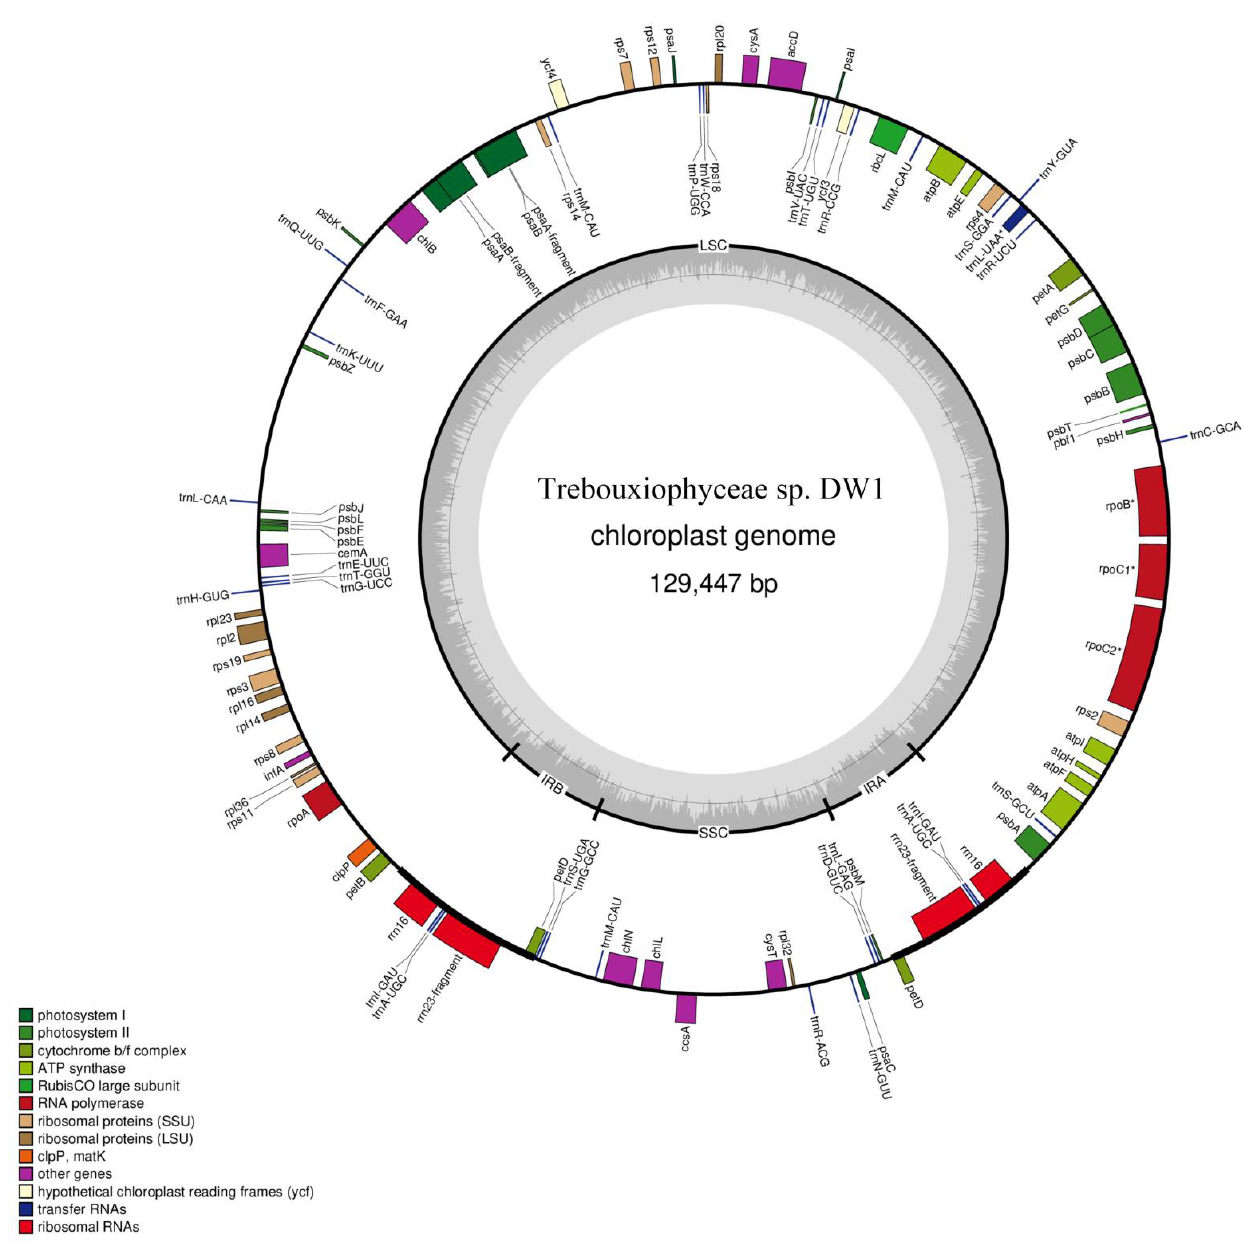
Figure 2. Gene map of the complete chloroplast genome of the green algae. Trebouxiophyceae sp. DW1. The genes inside the circle are transcribed clockwise, and the genes outside the circle are transcribed counterclockwise. Genes with introns are marked with an asterisk. The dark gray and light gray of the outer circle correspond to the LSC and SSC regions, respectively. The two regions are, respectively, represented as IRA and IRB, between LSC and SSC regions.